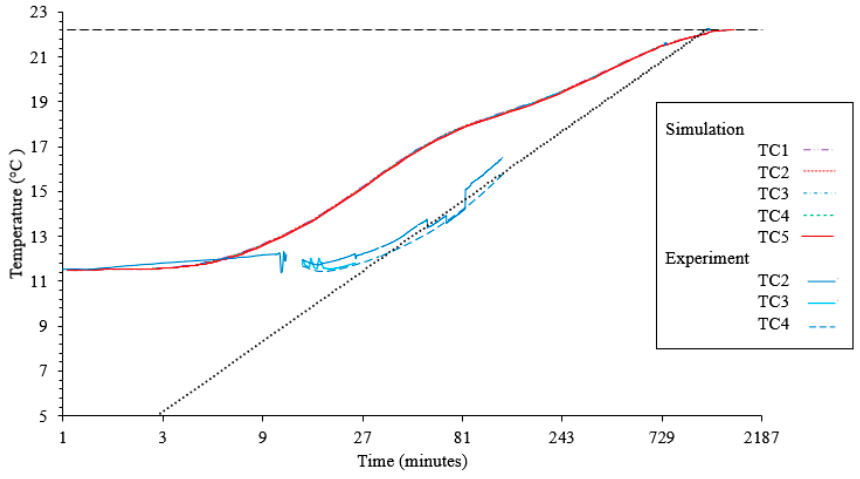
Figure 8. Comparison of simulated thermal change with experimental data.